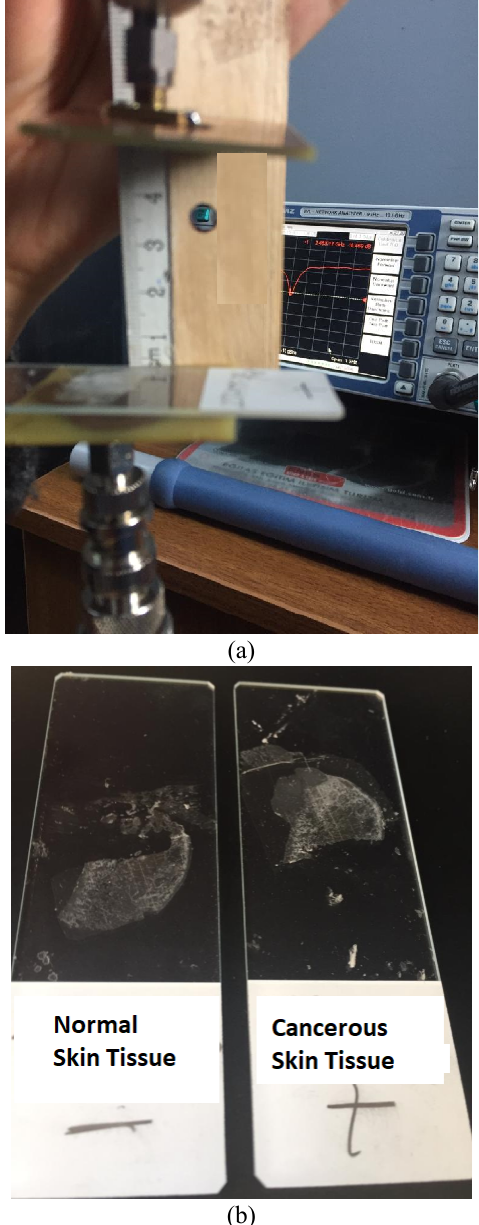
Figure 4: Experimental setup (a) and the glass slides